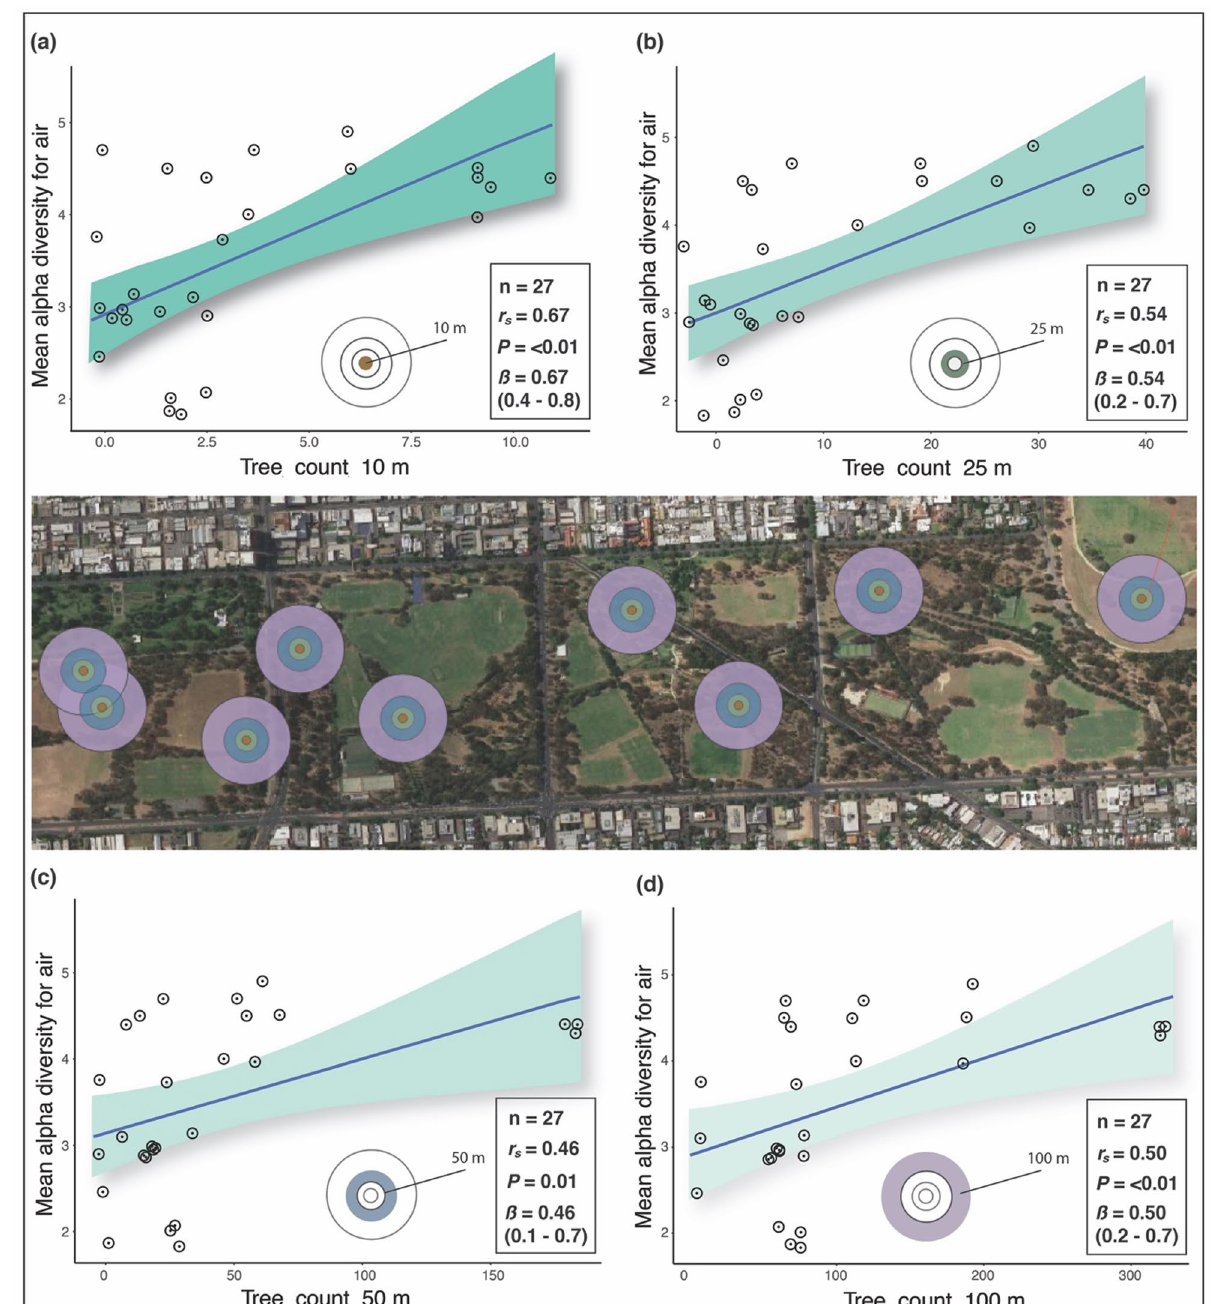
Figure 5. Scatterplots of Spearman’s correlations ( r s ) between bacterial alpha diversity (for all habitats and air-only samples) and tree count within each buffer radius: ( a ) 10 m radius from sampling points, ( b ) 25 m radius, ( c ) 50 m radius, and ( d ) 100 m radius. X-axis shows count of trees within buffer radii. Y-axis shows bacterial alpha diversity of air-only samples using the Shannon diversity index (H). Green shading indicates the 95% confidence intervals for each linear regression. The buffer radii are in the central aerial image and the corresponding spatial rings are in the plots. Inset also shows bootstrap results (β) with 2.5% and 97.5%